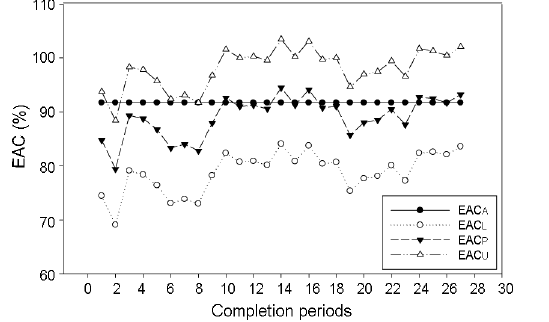
Fig. 8. EAC-LSMLPI prediction for project 12